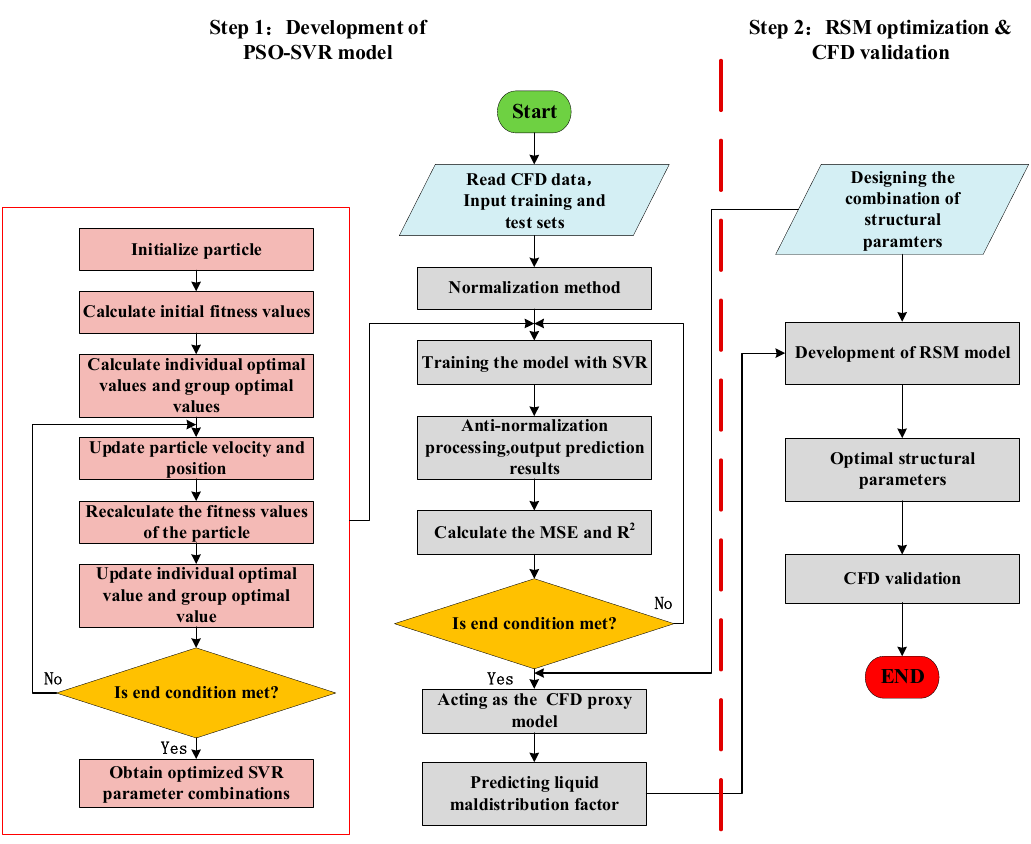
Figure 1. The flow chart for obtaining an optimized solution of the gas-liquid distributor in trickle-bed reactors (TBRs).